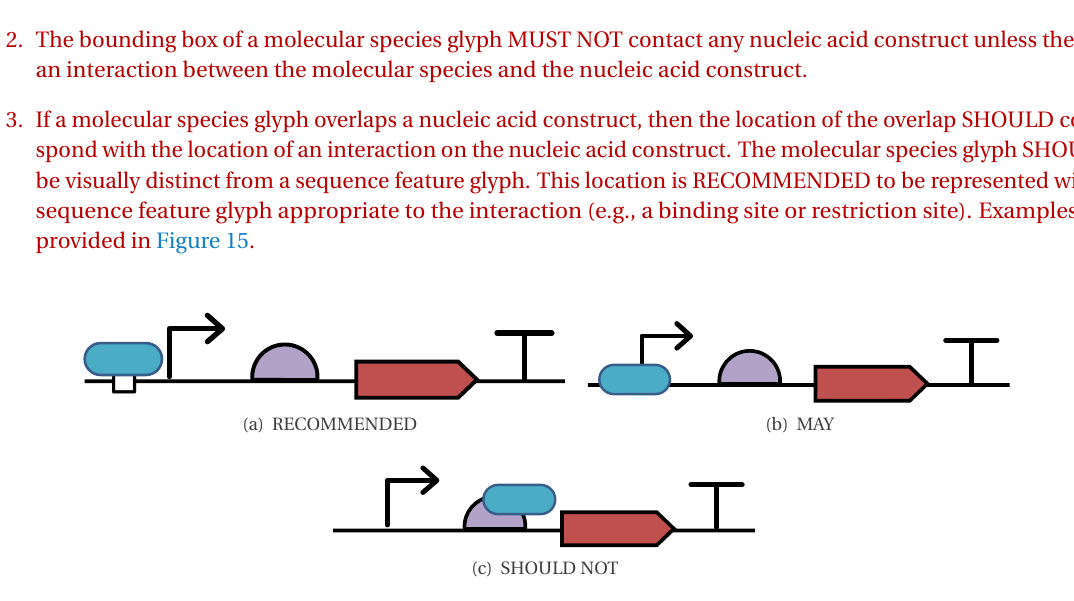
Figure 15: Examples of recommended, allowed, and not recommended representation of an interaction between a molecular species and a nucleic acid construct, in this case regulation of a promoter by a transcription factor protein that binds on the 5’ side of the promoter: (a) shows the RECOMMENDED representation, (b) shows a more generic alternative, and (c) is recommended against because the location does not corresponding with the binding.